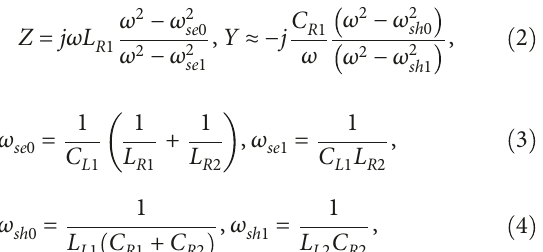
Figure 2: The impact of structure parameters on the equivalent circuit parameters, (a) G of via; (c) L , length of transverse slots; (d) L 1 and f sh is 11.79GHz and 10.99GHz,